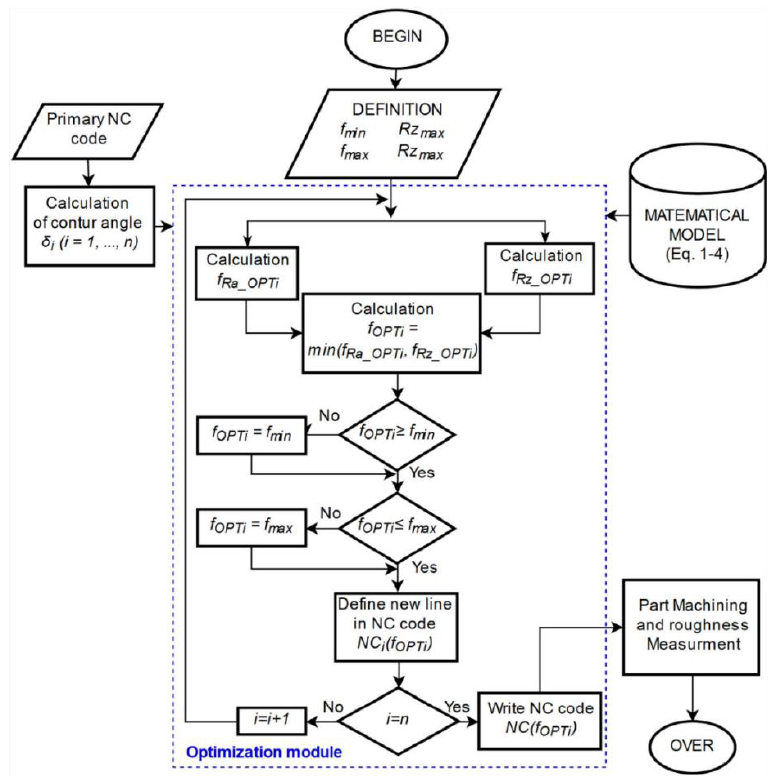
Figure 11. Algorithm of the optimization method of feed rate values.